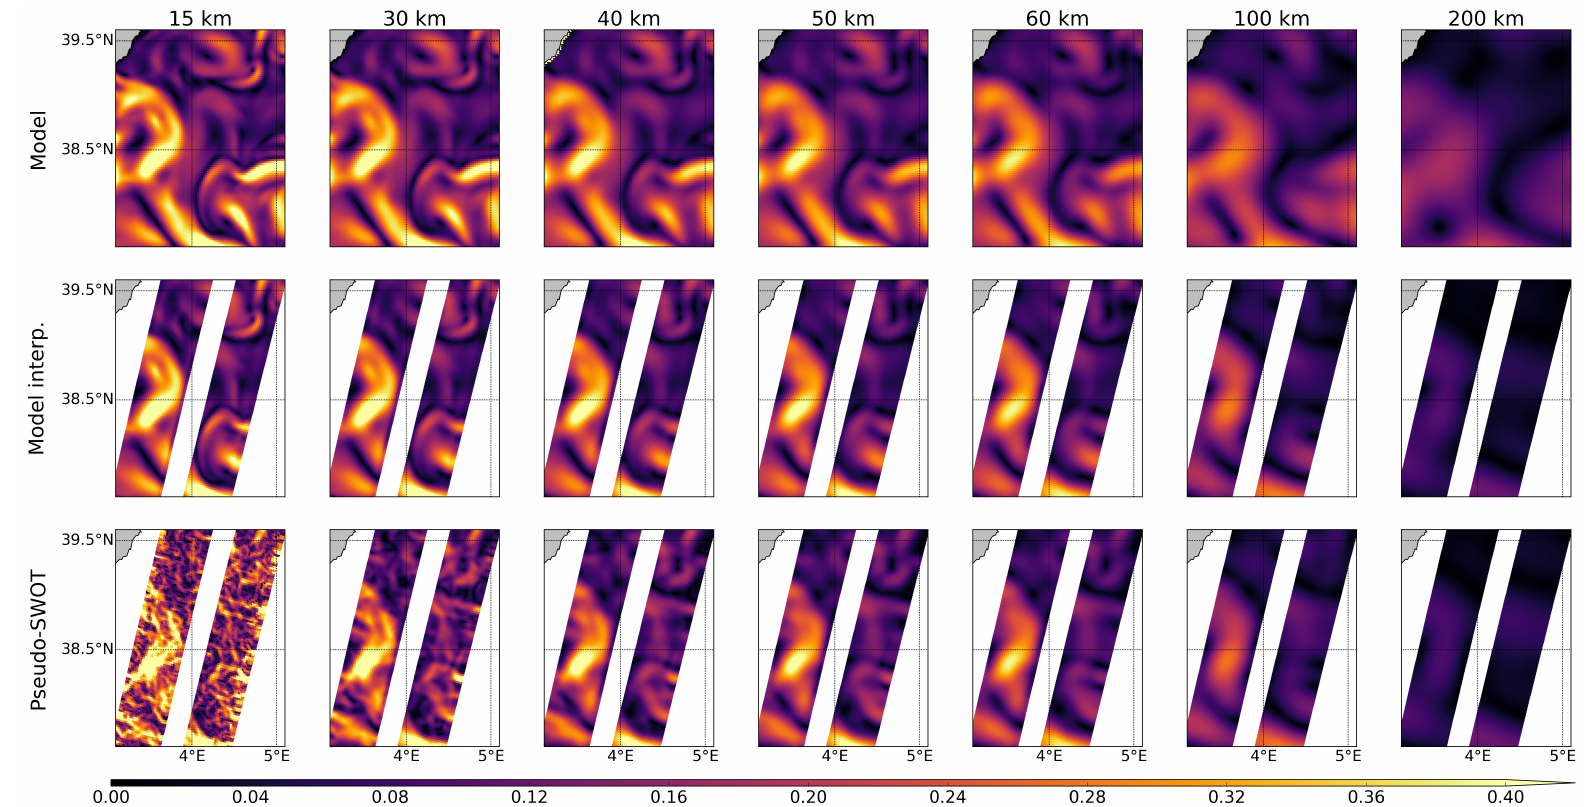
Figure 10. Absolute geostrophic velocity (m/s) on 3 February 2009 corresponding to pass 168 of cycle